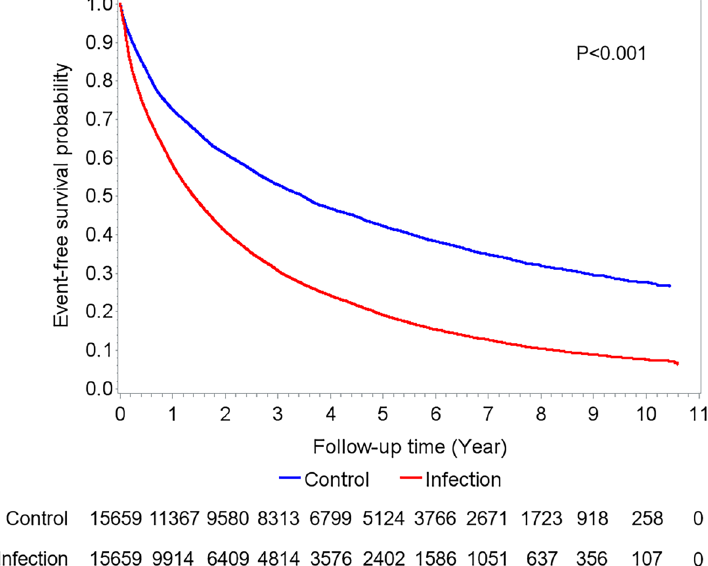
Figure 2. Kaplan–Meier curve for the primary composite endpoint. The blue and orange lines represent event-free survival in the infection and control groups, respectively. The negative impact of infection is not only present in the acute or subacute phase, but also persists during long term follow-up.